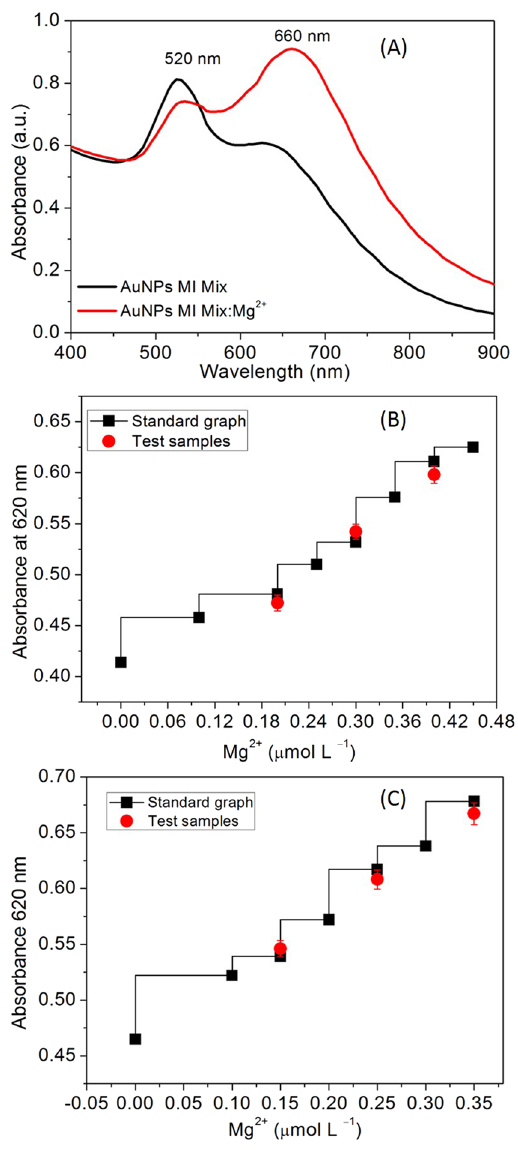
Figure 7. ( A ) UV-Vis response of the AuNPs upon the addition of Mg 2 + (0.530 μ mol L − 1 ) to the solution containing a mixture of the metal ions, ( B ) The curve of the AuNPs absorbance intensity at 620 nm vs. urine samples spiked with Mg 2 + was tested in the in the range of 0.1 to 0.45 µ mol L − 1 , ( C ) The curve of the AuNPs absorbance intensity at 620 nm vs. artificial serum samples spiked with Mg 2 + was tested in the range of 0.1 to 0.35 µ mol L − 1